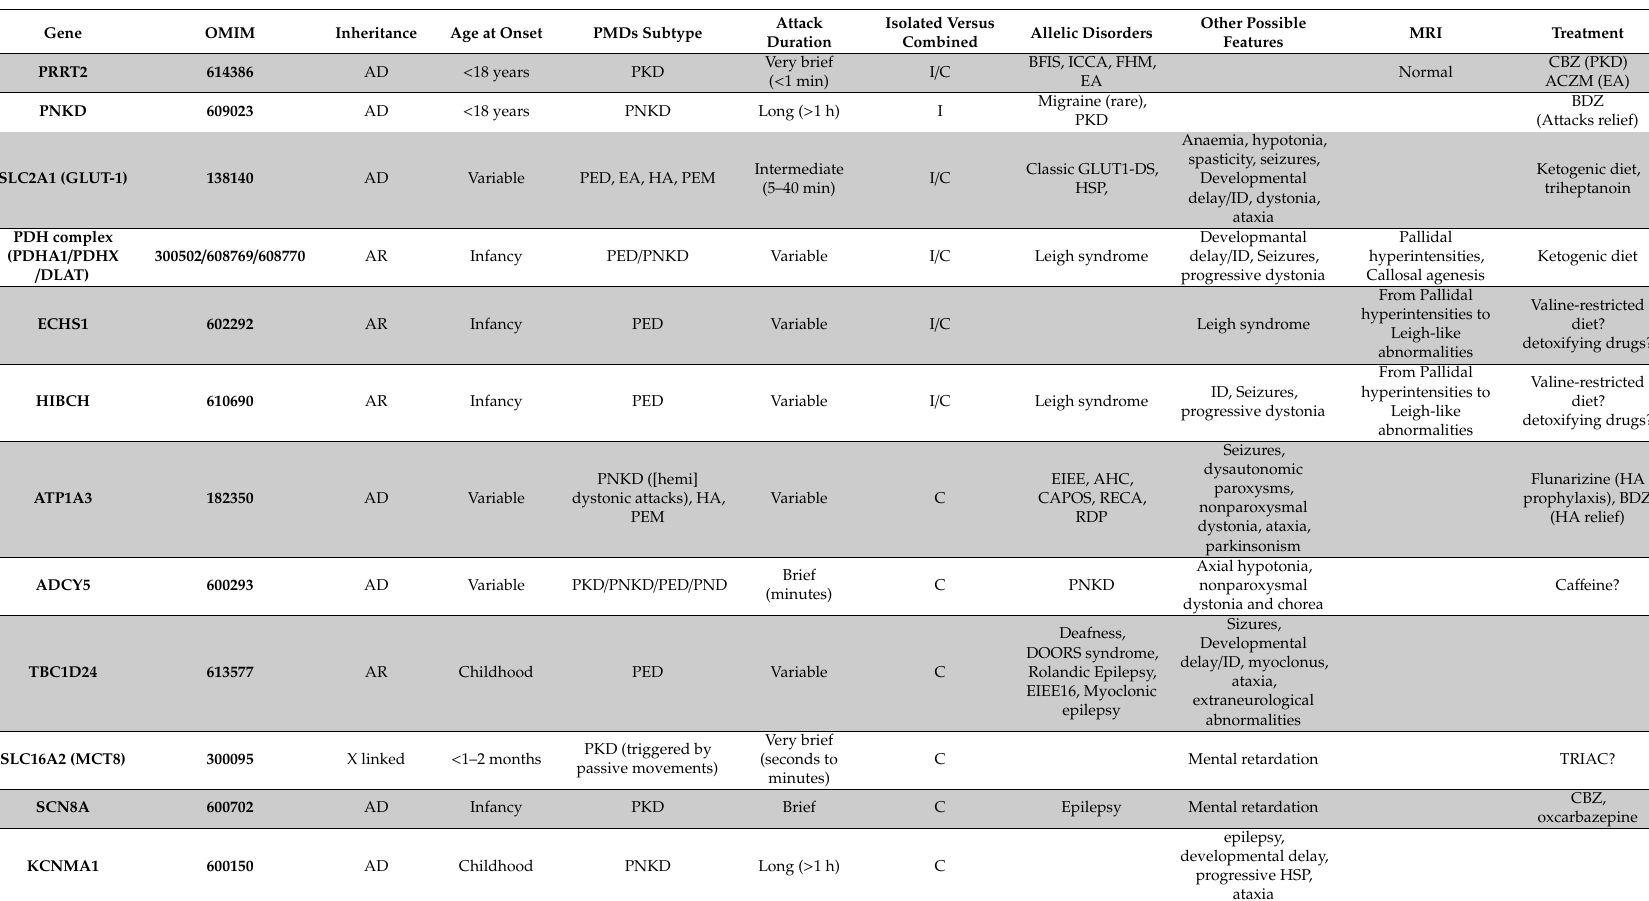
Table 1. Main genetic causes of paroxysmal movement disorders. A question mark follows treatment options that: have been proposed basing on pathophysiological assumptions, are under investigation or have been shown to be beneficial only in single-case